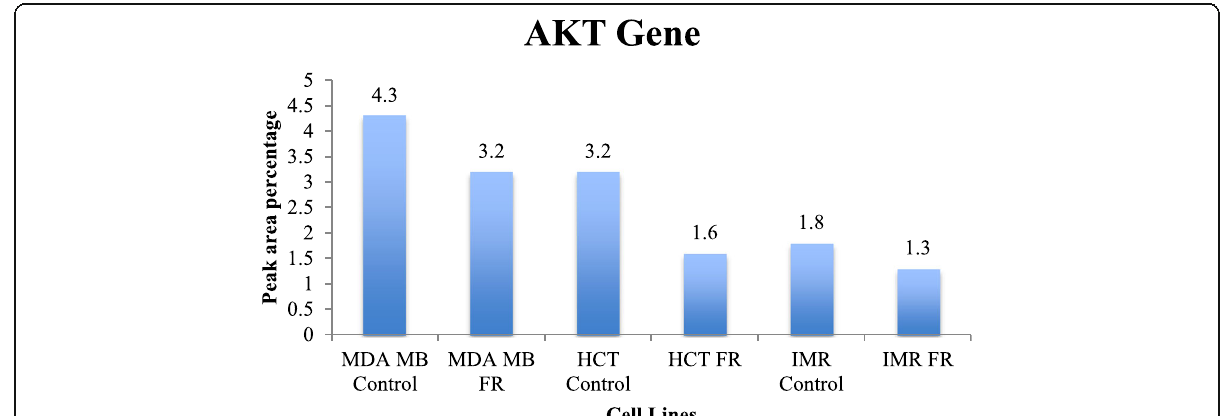
Fig. 12 The relative gene expression of AKT gene in all the cell lines. FR — Ficus